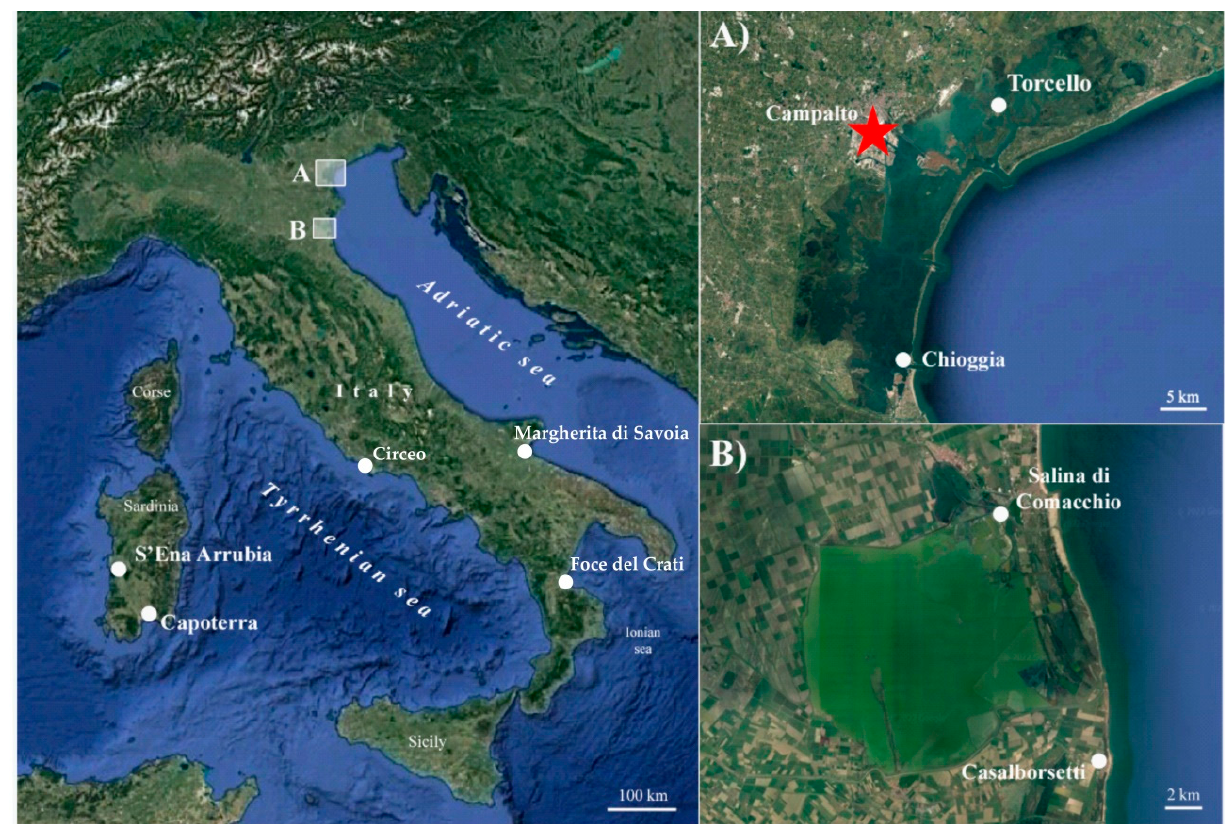
Figure 1. Map of the Salicornia populations investigated in this study. ( A ) Focus on Veneto sampling sites; the red star indicates the locus classicus of S. veneta . ( B ) Focus on Emilia-Romagna sampling sites.